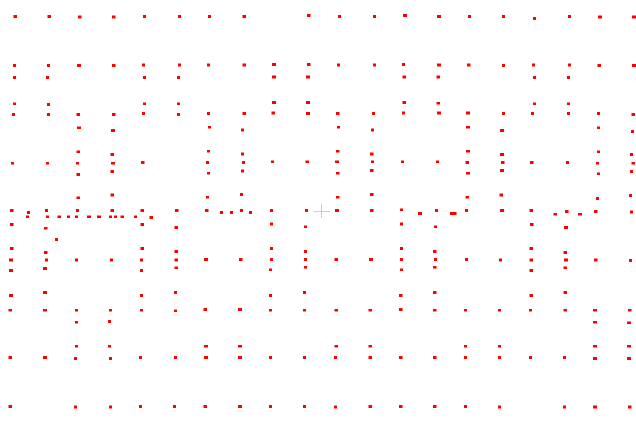
Figure 6. Mean-shift clustering results.